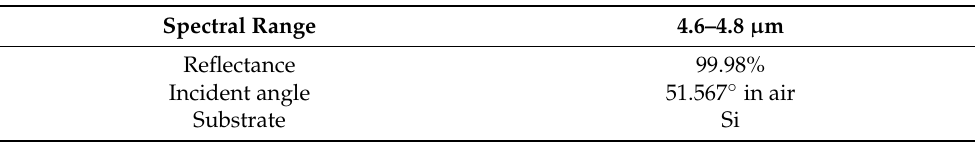
Table 3. Parameter requirements for high-reflection